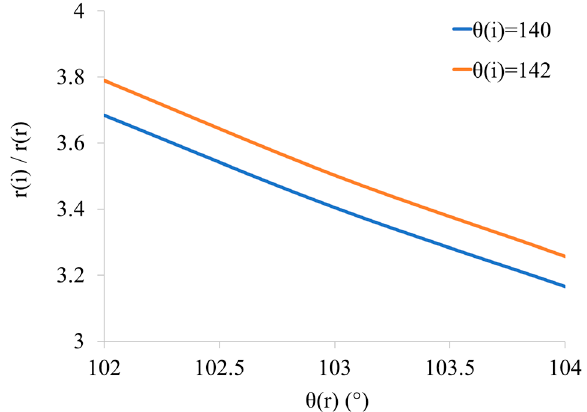
Figure 5. Ratios between the pore size r ( i ) obtained for the retraction of mercury when considering the same contact angle θ ( i ) as for advancing mercury (140 or 142 °) and the pore size r ( r ) for the retraction of mercury when considering a smaller contact angle θ ( r ) (102 or 104 °) for the receding mercury.